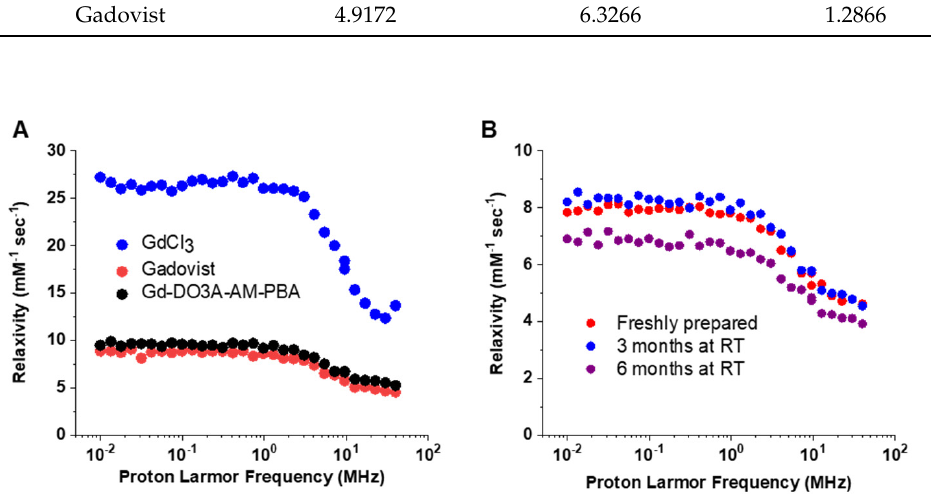
Figure 3. ( A ) Measured 1/ T 1 NMRD profiles of Gd-DO3A-Am-PBA (black), Gadovist (red), and GdCl 3 (blue) with 2 µ mol of gadolinium. ( B ) Measured 1/T 1 NMRD profiles of freshly prepared GdCl 3 (blue) with 2 μ mol of gadolinium. ( B ) Measured 1/T 1 NMRD profiles of freshly prepared (red) (red) and three months (blue) and six months (purple) room temperature stored Gd-DO3A-Am-PBA. All measurements were made in pure water, pH 7, at 25 ◦